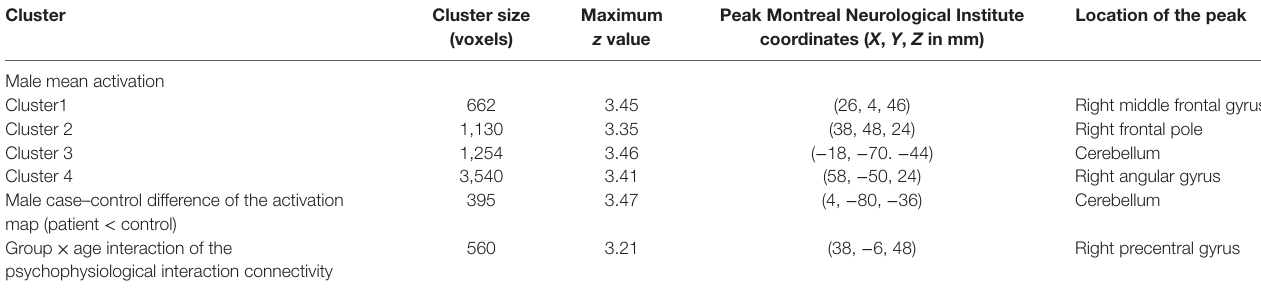
TaBle 5 | Significant fMRI mean activation, group difference, and group × age interaction of the connectivity between the cerebellum and the superior frontal gyrus responding to the sad distractor contrast . cluster cluster size (voxels)